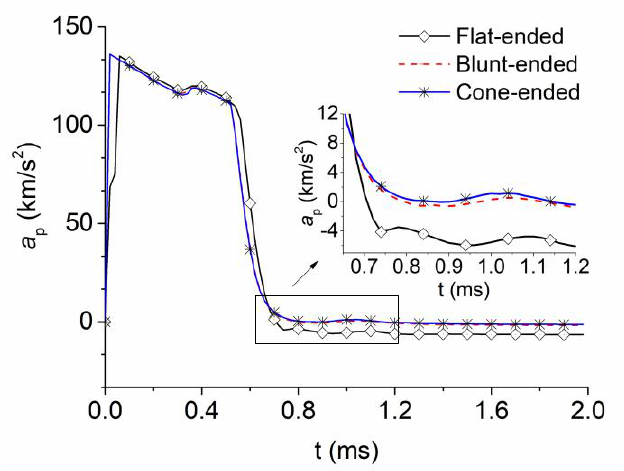
Figure 11. Acceleration and deceleration history of the projectiles.